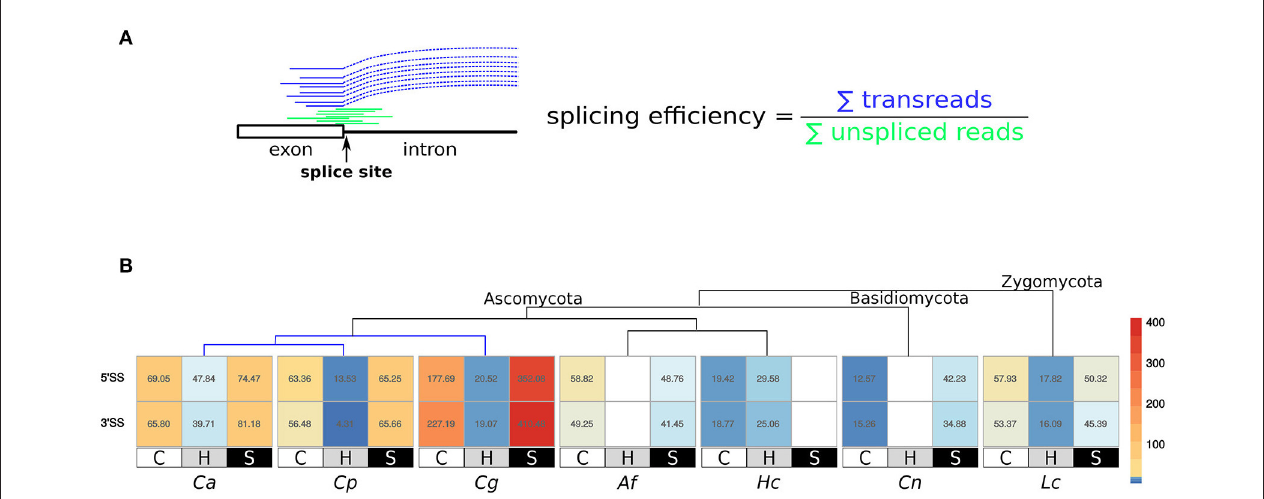
FIGURE 5 | (A) The concept of splicing efficiency. For each splice site (SS), we calculated the number of transreads spanning the boundary between exon and intron (reads that are split at a specific splice site), and the number of reads covering the nearest intron position of the splice site ( Prevorovsky et al., 2016). (B) Splicing efficiency during control (C), response-to-host (H) and other stress conditions (S) for each species. The values are summarized for all 5 ′ and 3 ′ SSs.